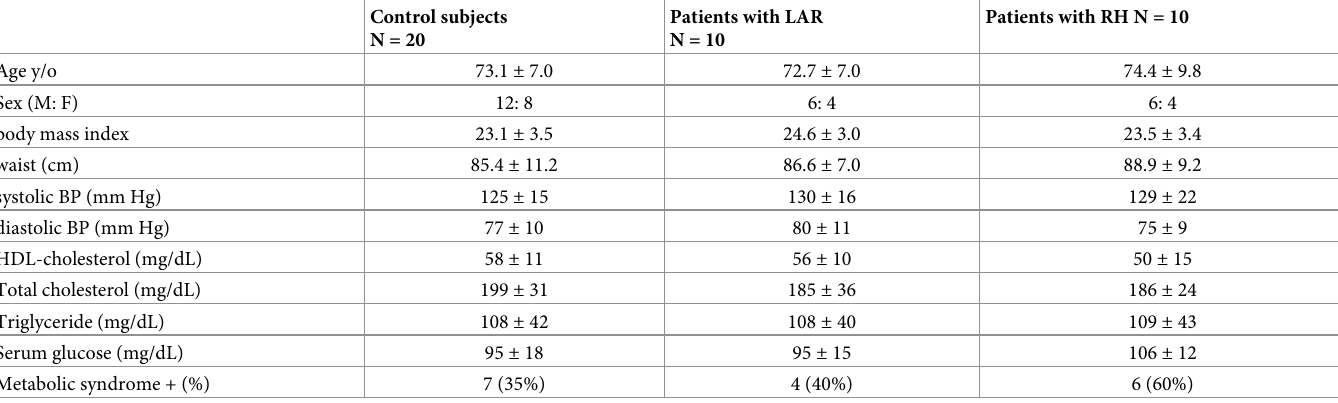
Table 2. Anthropometric and laboratory data between patients with partial colectomy (right hemicolectomy or low anterior resection) and controls with fecal